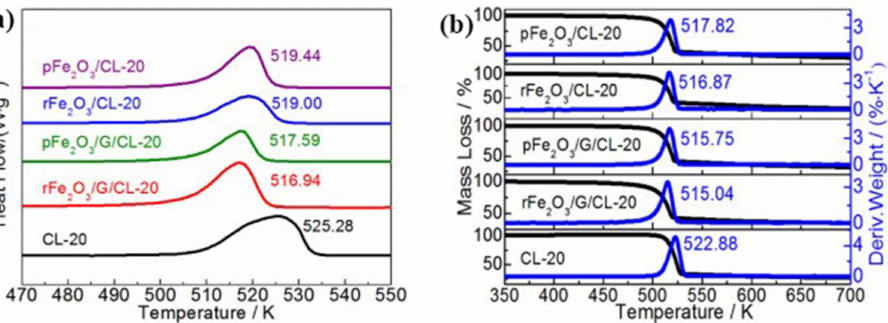
Figure 16. ( a ) DSC and ( b ) TG-DTG curves of CL-20 mixed with different catalysts. ( a , b ) Reproduced with the permission of ref. [98]. Copyright 2020, Acta Physico-Chimica Sinica.